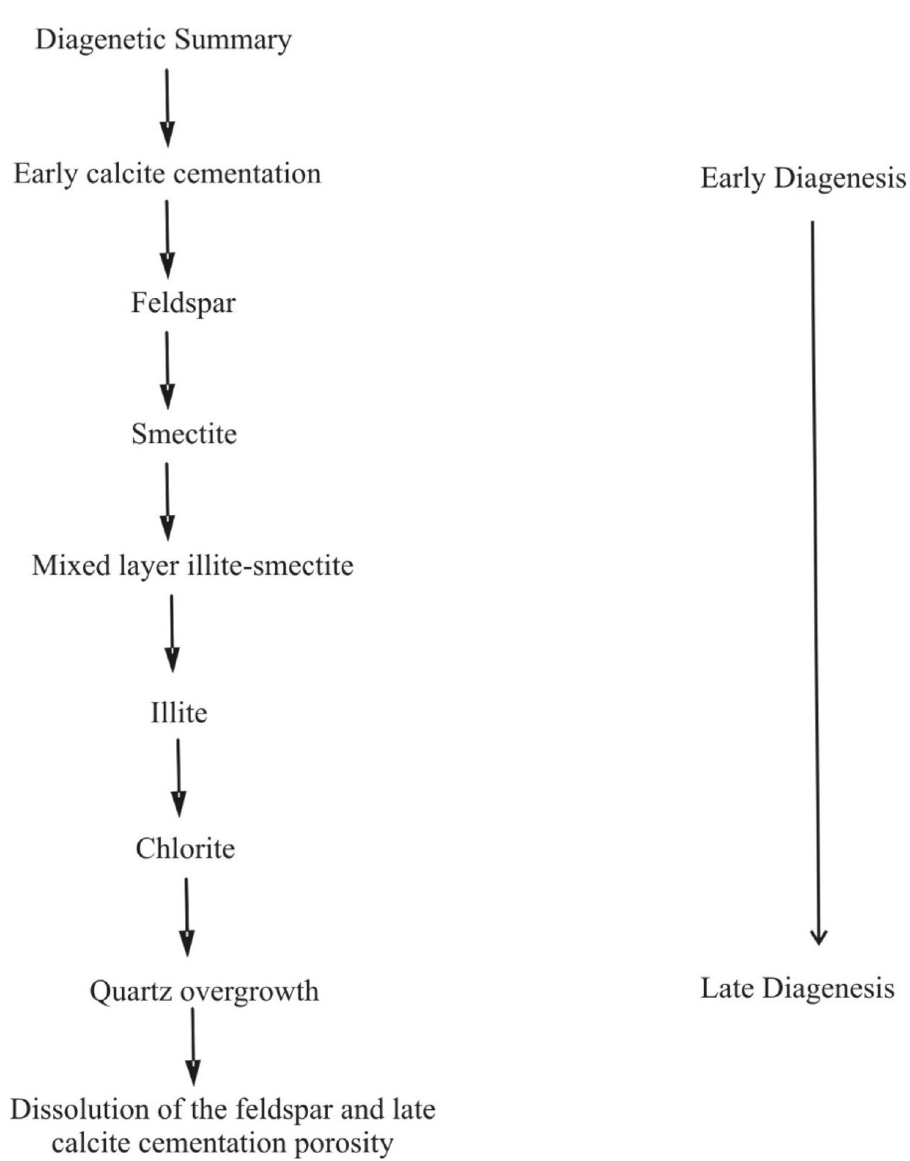
Fig. 10 Diagenetic sequence of the Haymana Formation of the Haymana